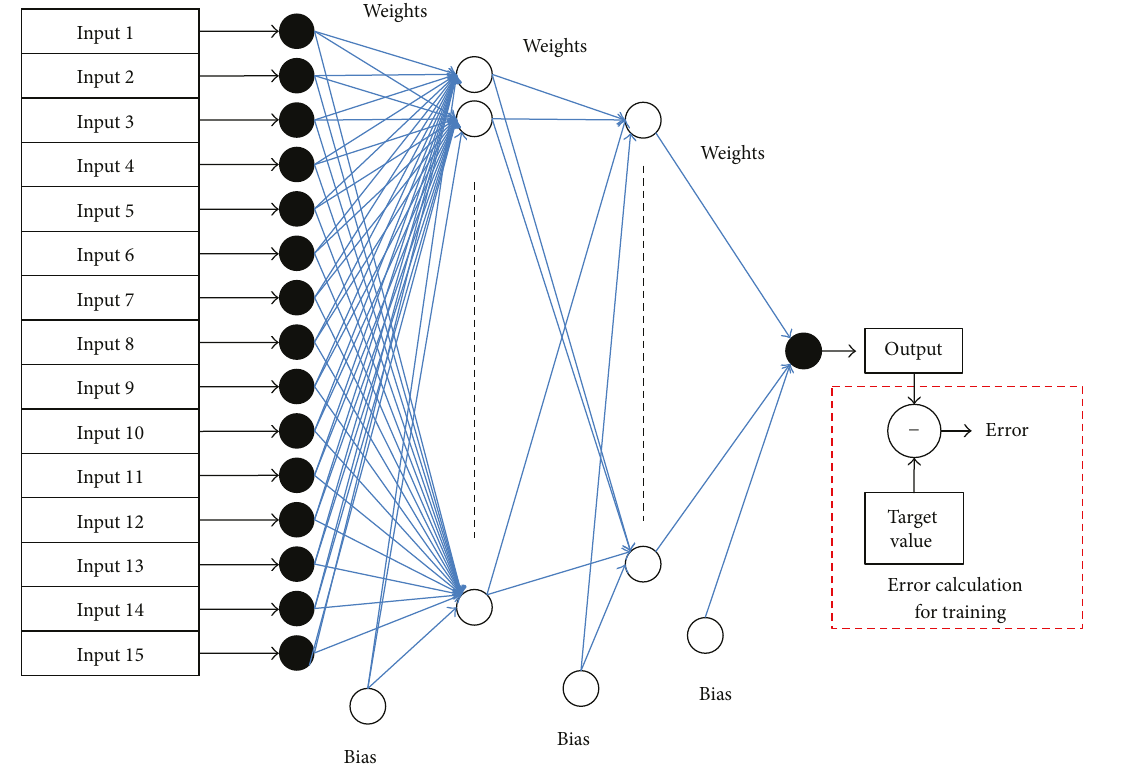
Figure 7: Diagram of the proposed method.